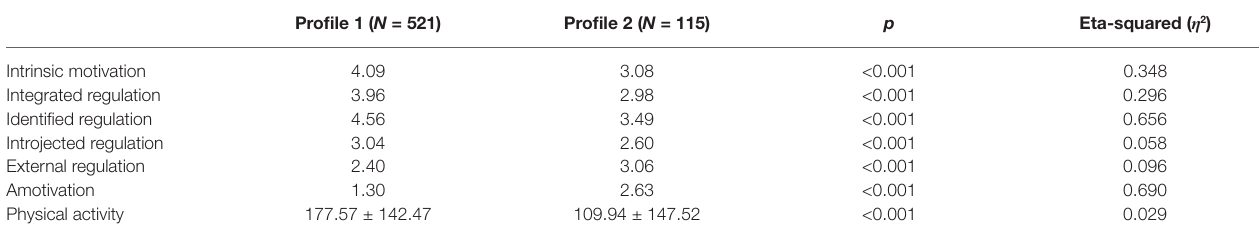
TABLE 4 | Differences across motivation